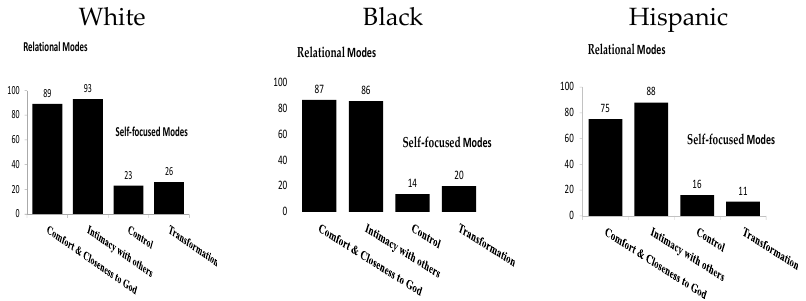
Figure 2. Hierarchy of Religious Coping Methods as a Proportion of all Religious Last Statements among Texas Death Row Inmates by Race/Ethnicity (7 December 1982–6 April 2016), (N = 269).